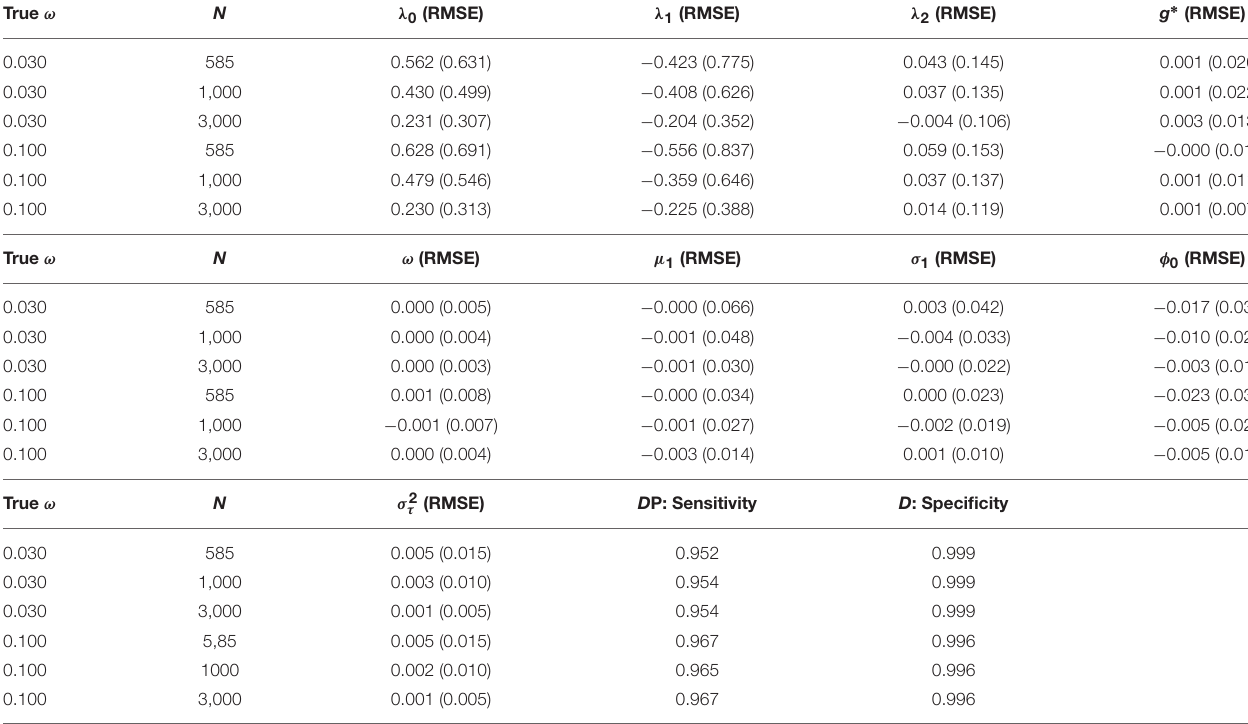
TABLE 6 | The bias and RMSE of the fixed parameter estimates under different simulation conditions and the specificity and sensitivity of the D i , t estimates. True ω